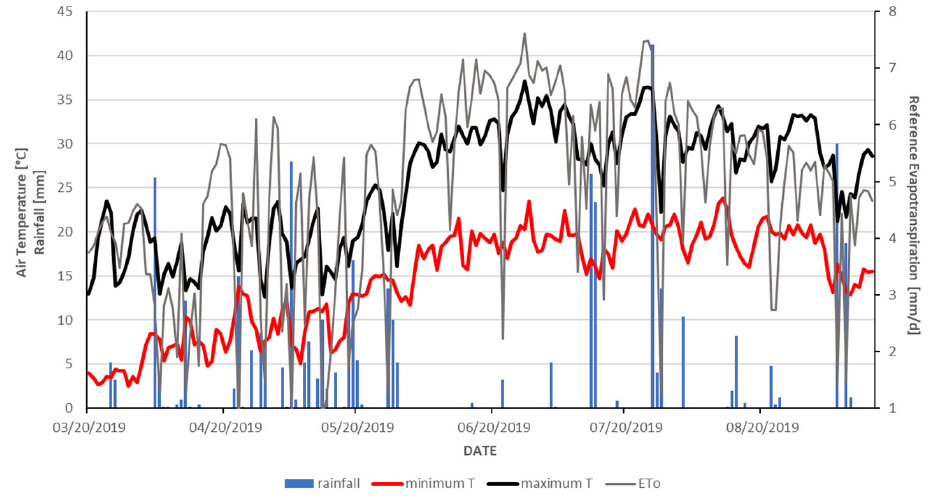
Figure 2. Daily maximum (black line), minimum (red line) air temperature, reference DSSAT evapotranspiration (gray line), and rainfall (blue vertical bars) during the 2019 growing season from the Agenzia Regionale per la Prevenzione e Protezione Ambientale del Veneto (ARPAV; http://www.arpa.veneto.it/, accessed on 1 July 2021) weather station in Rovigo.